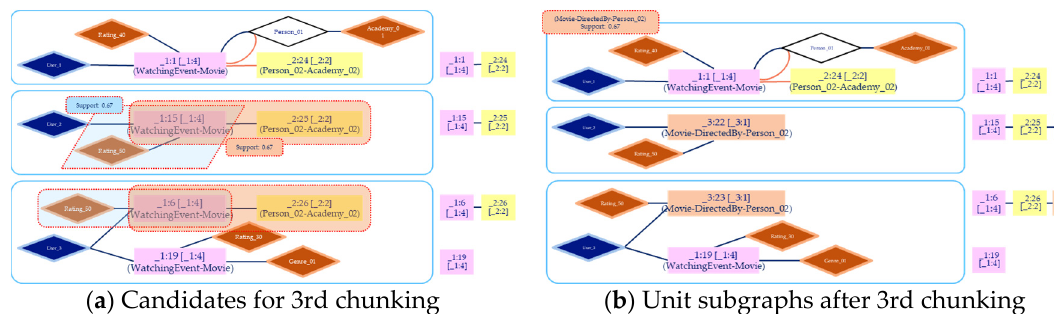
Figure 14. 3rd candidate generation and chunking result.